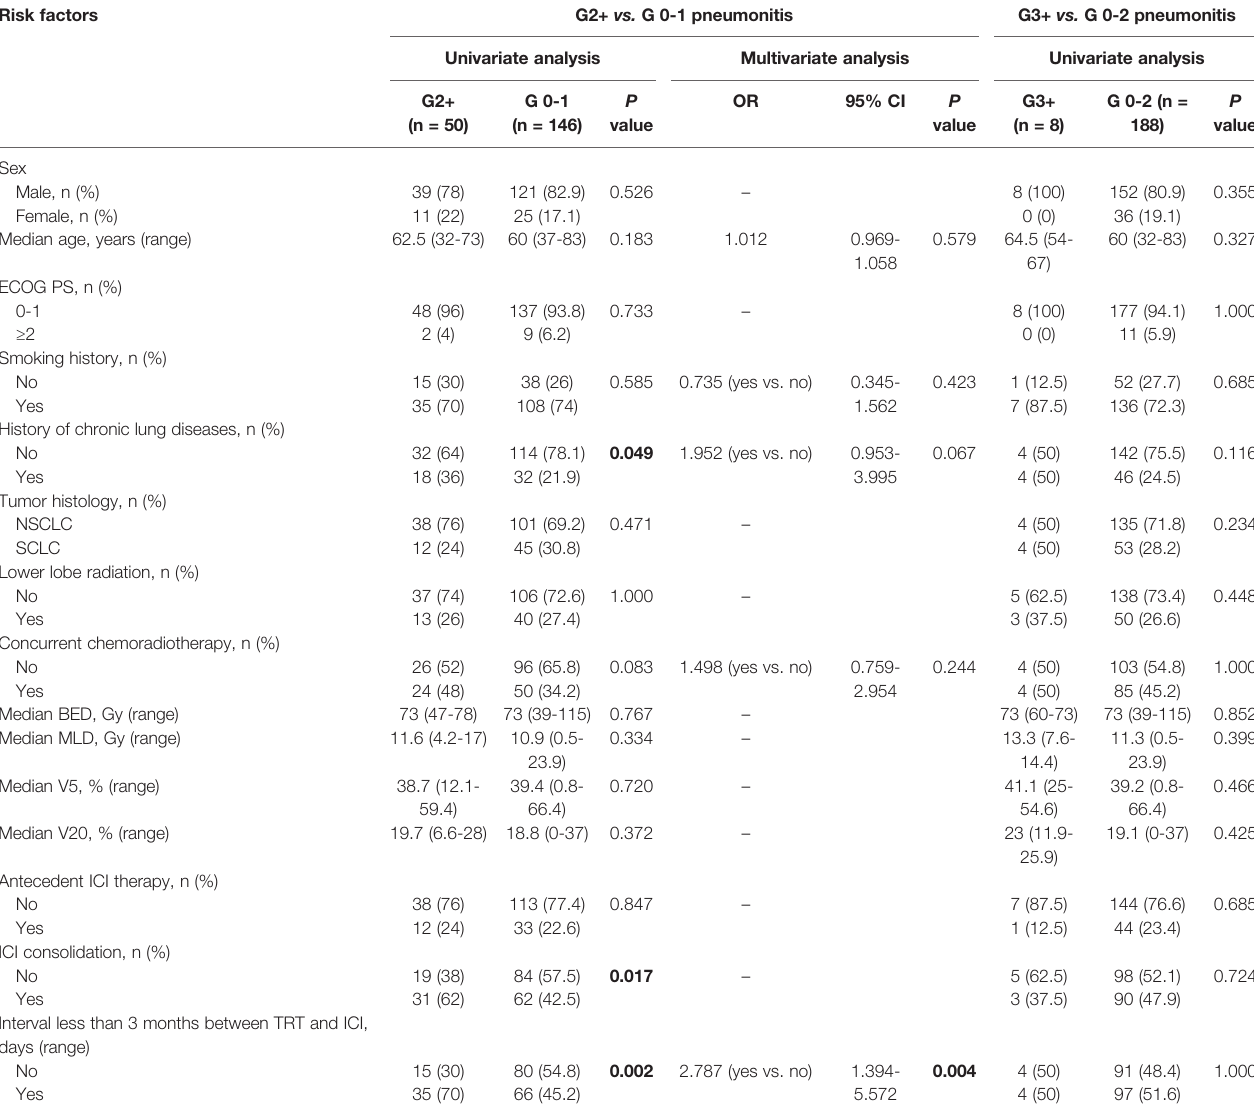
TABLE 4 | The associations between clinical, treatment, dosimetric variables and G2+ or G3+ treatment-related pneumonitis. Risk factors G2+ vs. G 0-1 pneumonitis G3+ vs. G 0-2